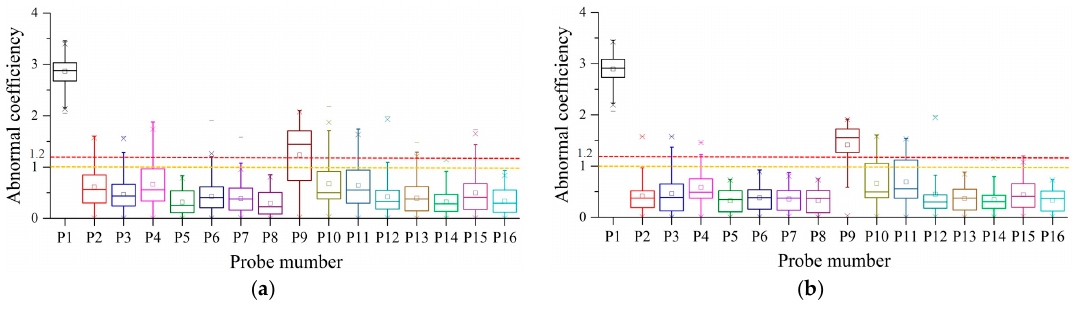
Figure 8. The abnormal coefficient boxplot of the ( a ) first 6 h and ( b ) the first 3 h of Vehicle 1.